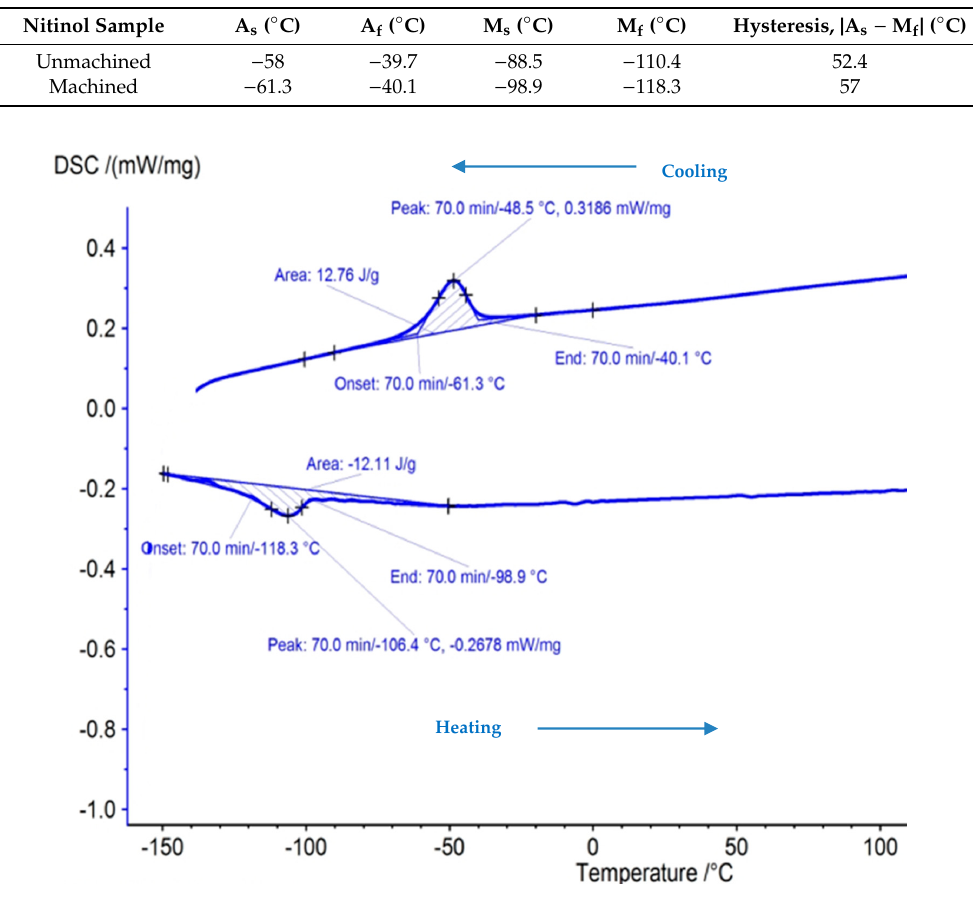
Table 7. Phase transformation temperatures and hysteresis.